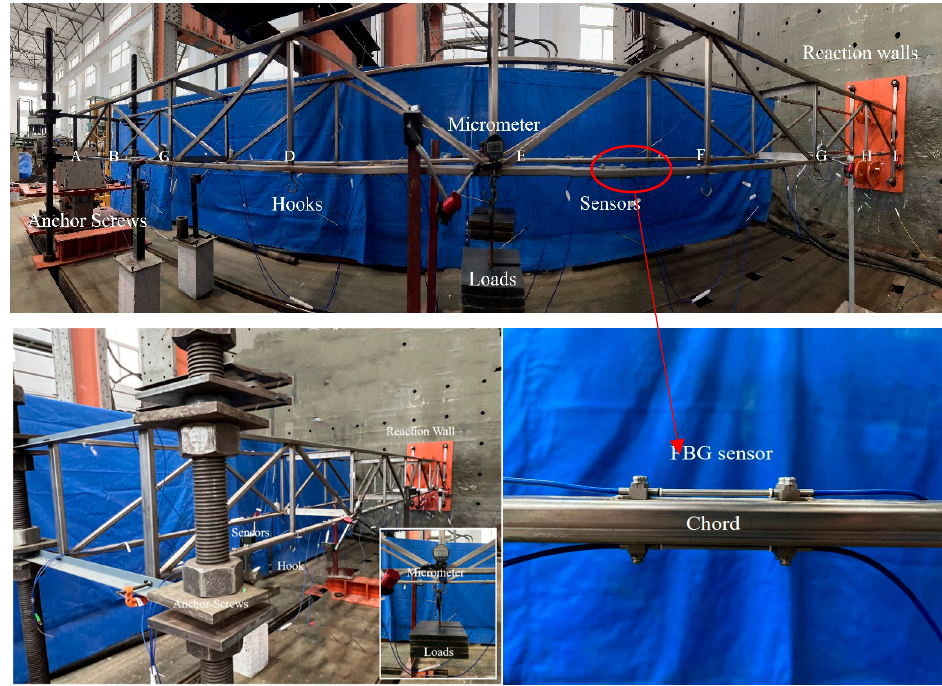
Figure 6. The test setup.